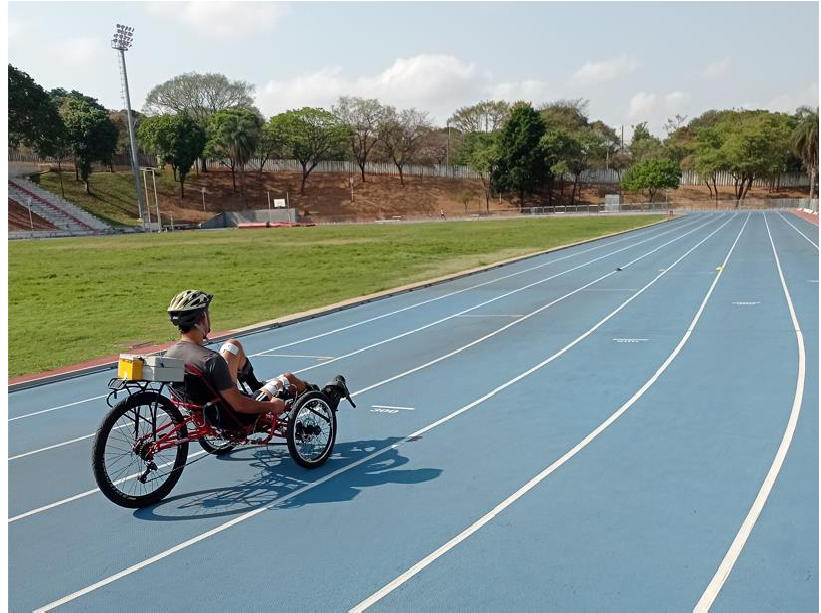
Figure 12. First FES-assisted cycling session on the athletics track of the UFMG Sports Training Center (CTE-UFMG). Video for demonstration: https://youtu.be/J9IXGMNagf0 (accessed on 20 August 2021).